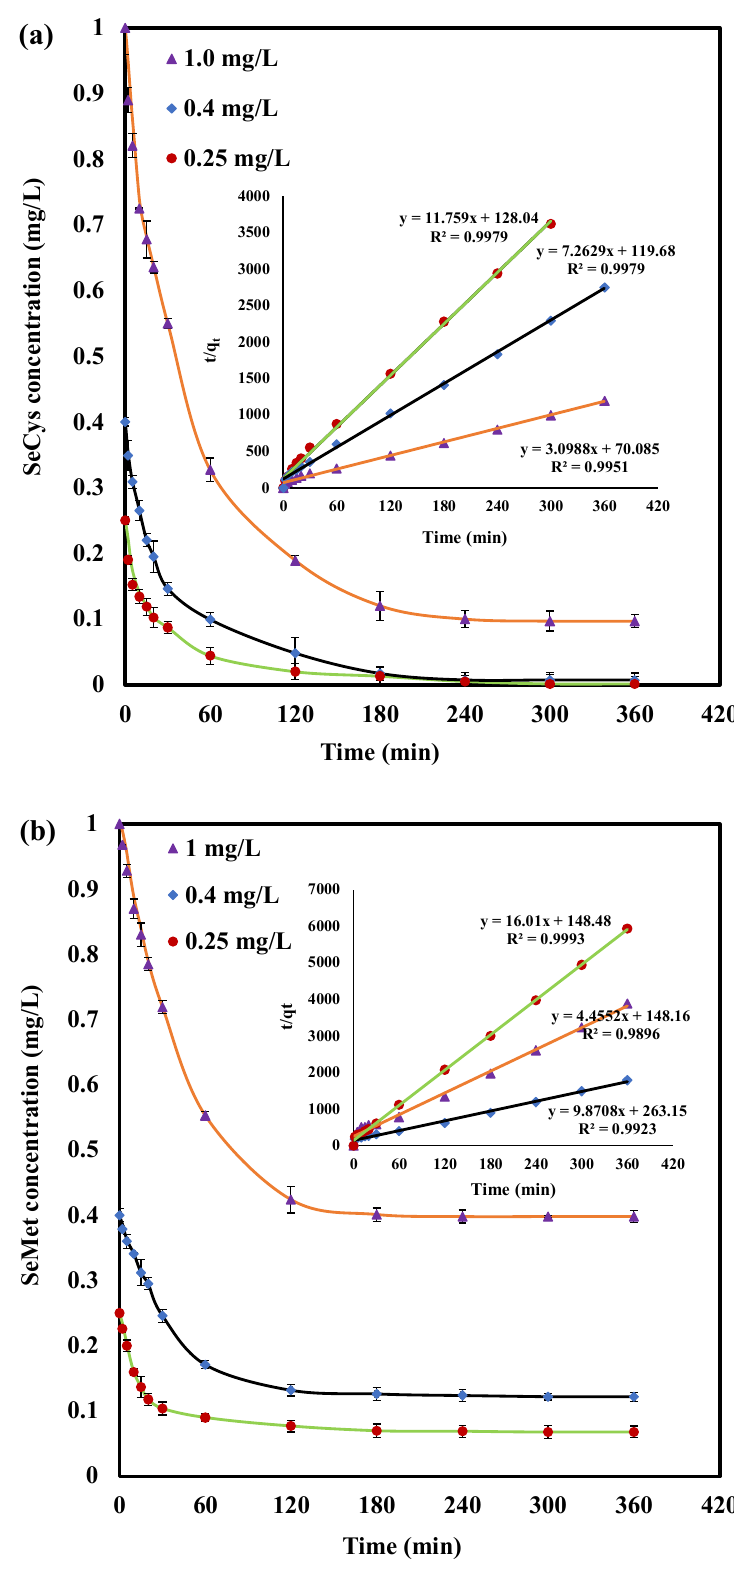
Figure 7. Effect of initial concentration: ( a ) SeCys and ( b ) SeMet: Initial concentration 1.0, 0.4 and 0.25 mg/L (all experiments were conducted at pH 7.0, 3 g/L of nZVI/GAC and 25 °C). Table 2. Key parameters on effects of initial SeCys and SeMet concentration adsorption onto nZVI/GAC.